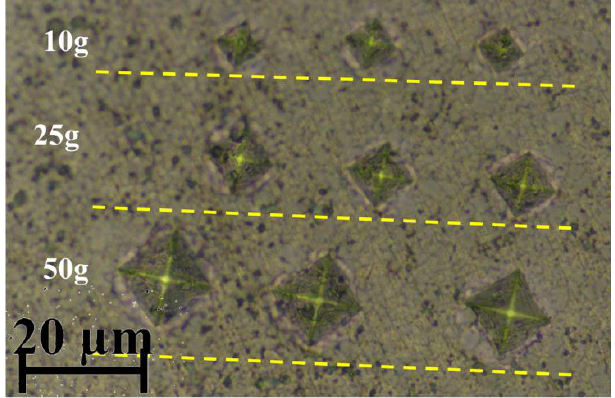
Figure 5. Indentation track of the Ni – Co – P/Si 3 N 4 composite coating.